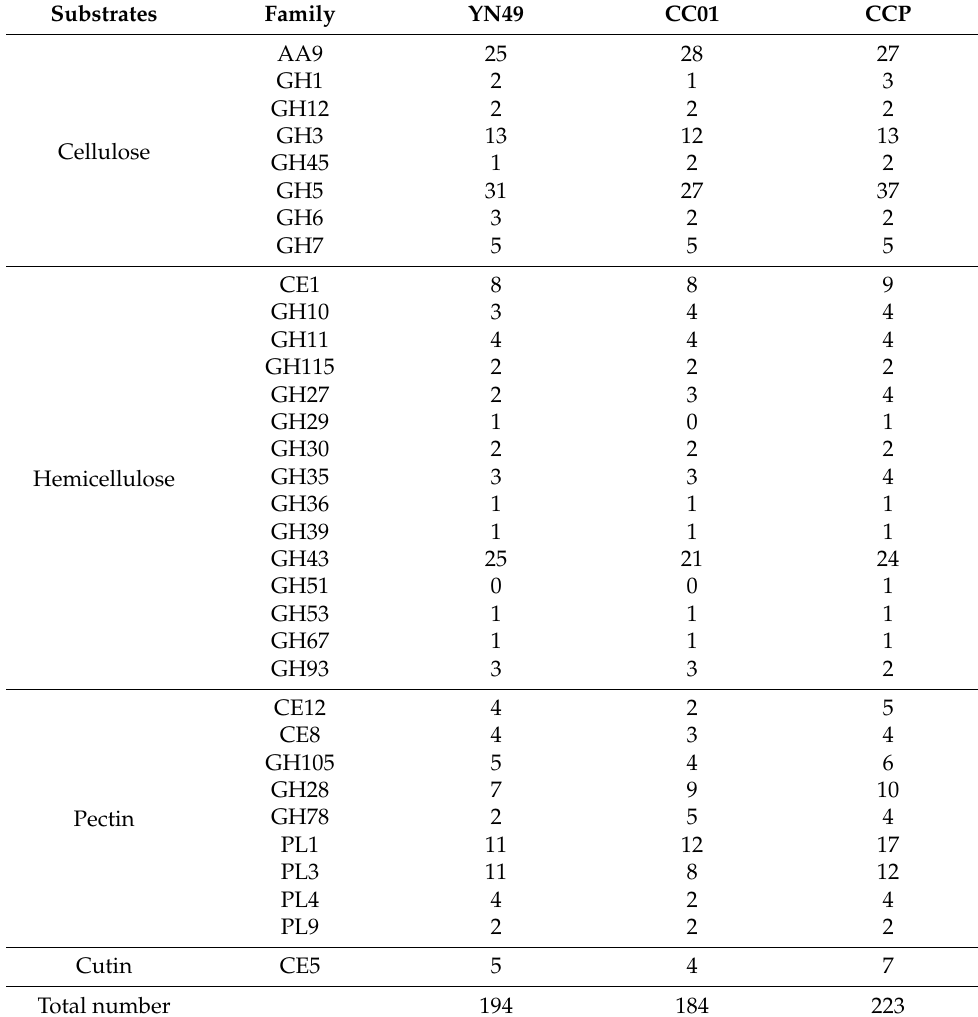
Table 2. CAZymes involved in plant cell wall